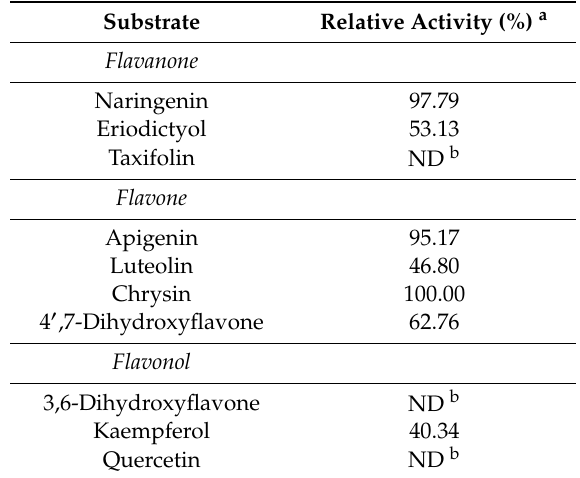
Table 1. Substrate preference of recombinant Perilla frutescens O -methyltransferase3